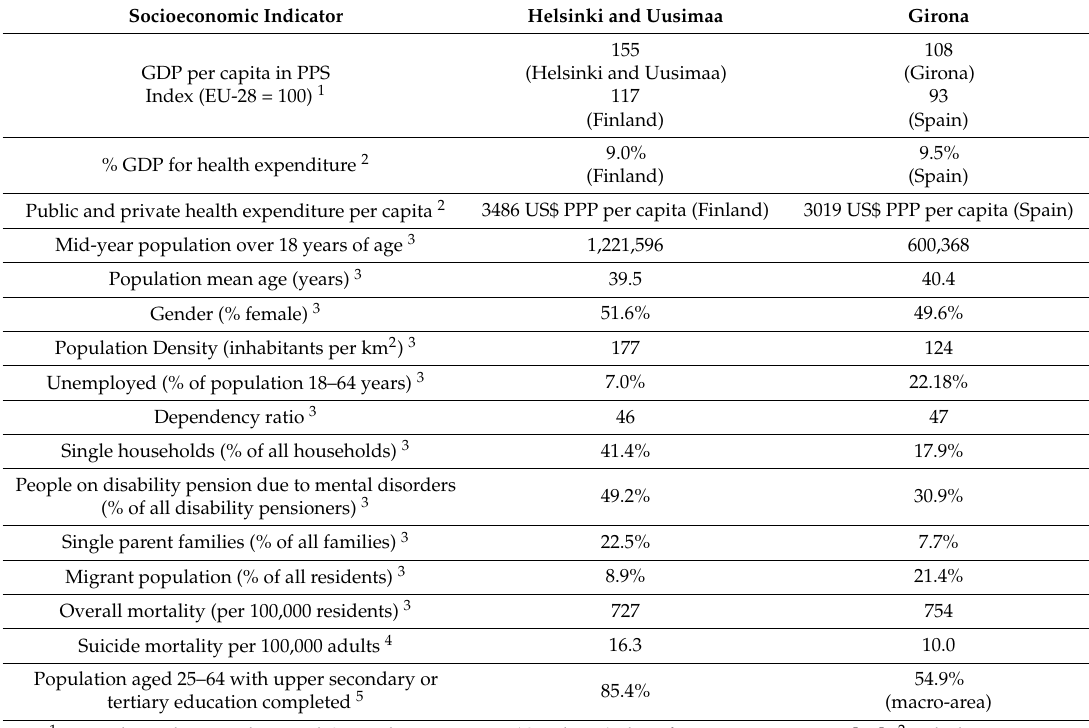
Table 1. Socioeconomic characteristics of the studied areas.